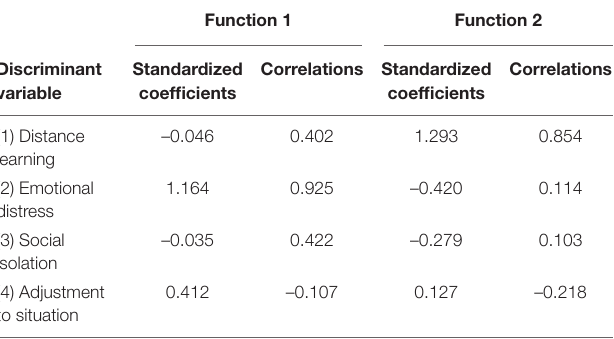
TABLE 4 | Standardized discriminant function coefficients and structure coefficients for the two significant canonical discriminant functions with groups defined by gender and cohorts of